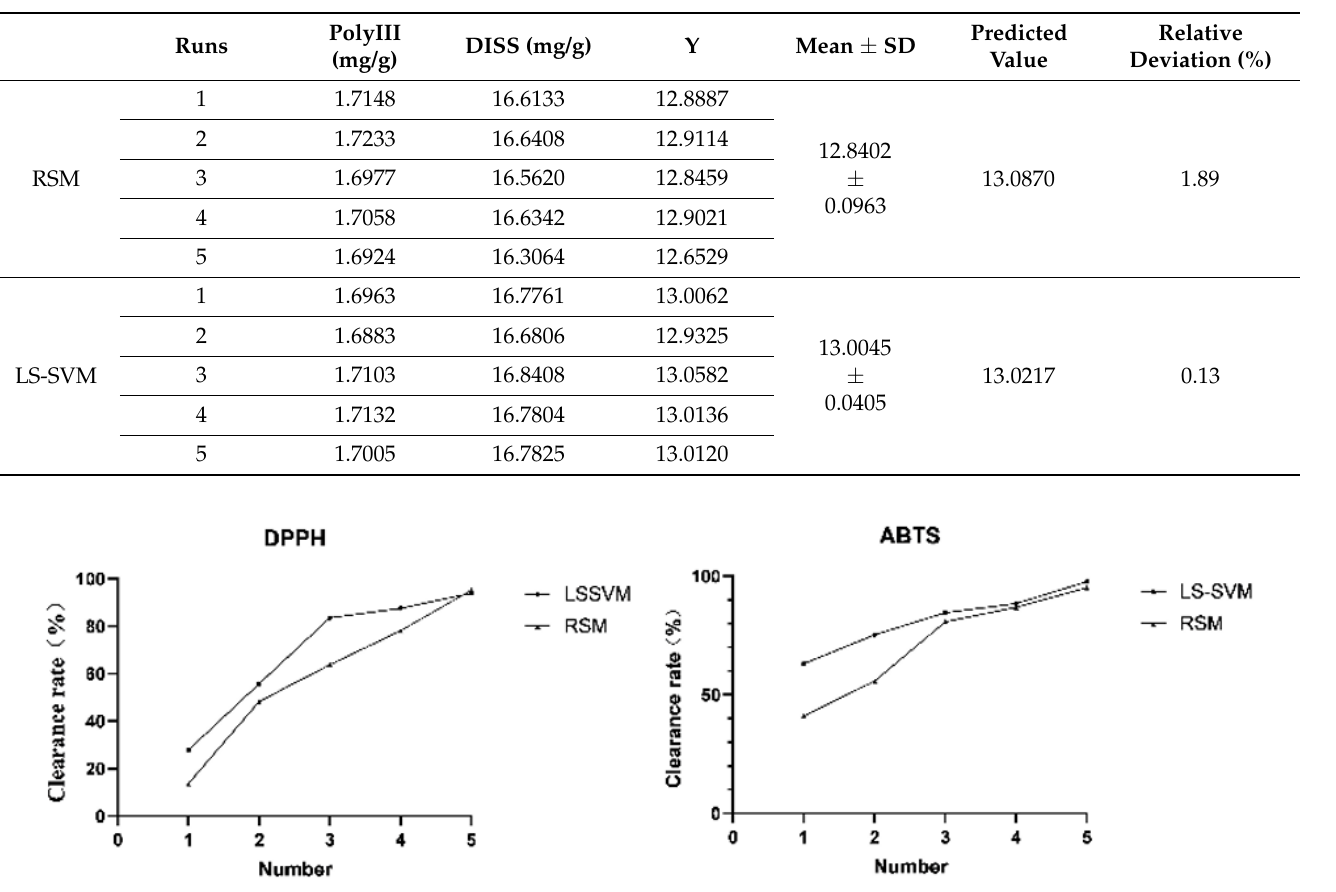
Table 5. Verification of experiment results.